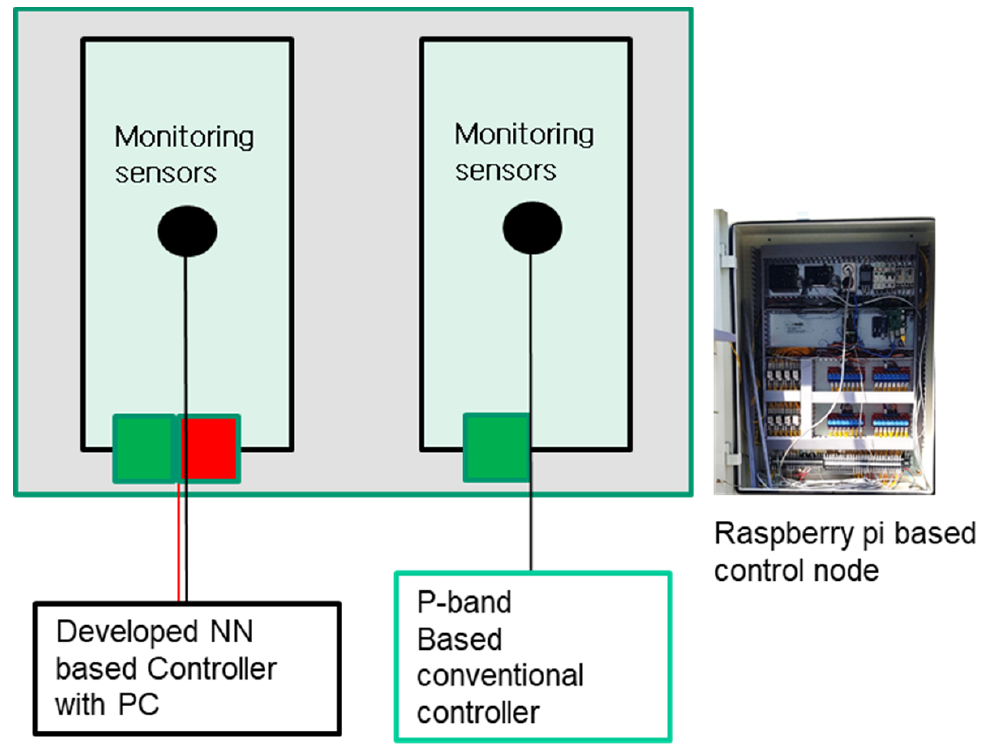
Figure 6. Comparative greenhouse and control node diagram for field application experiment.